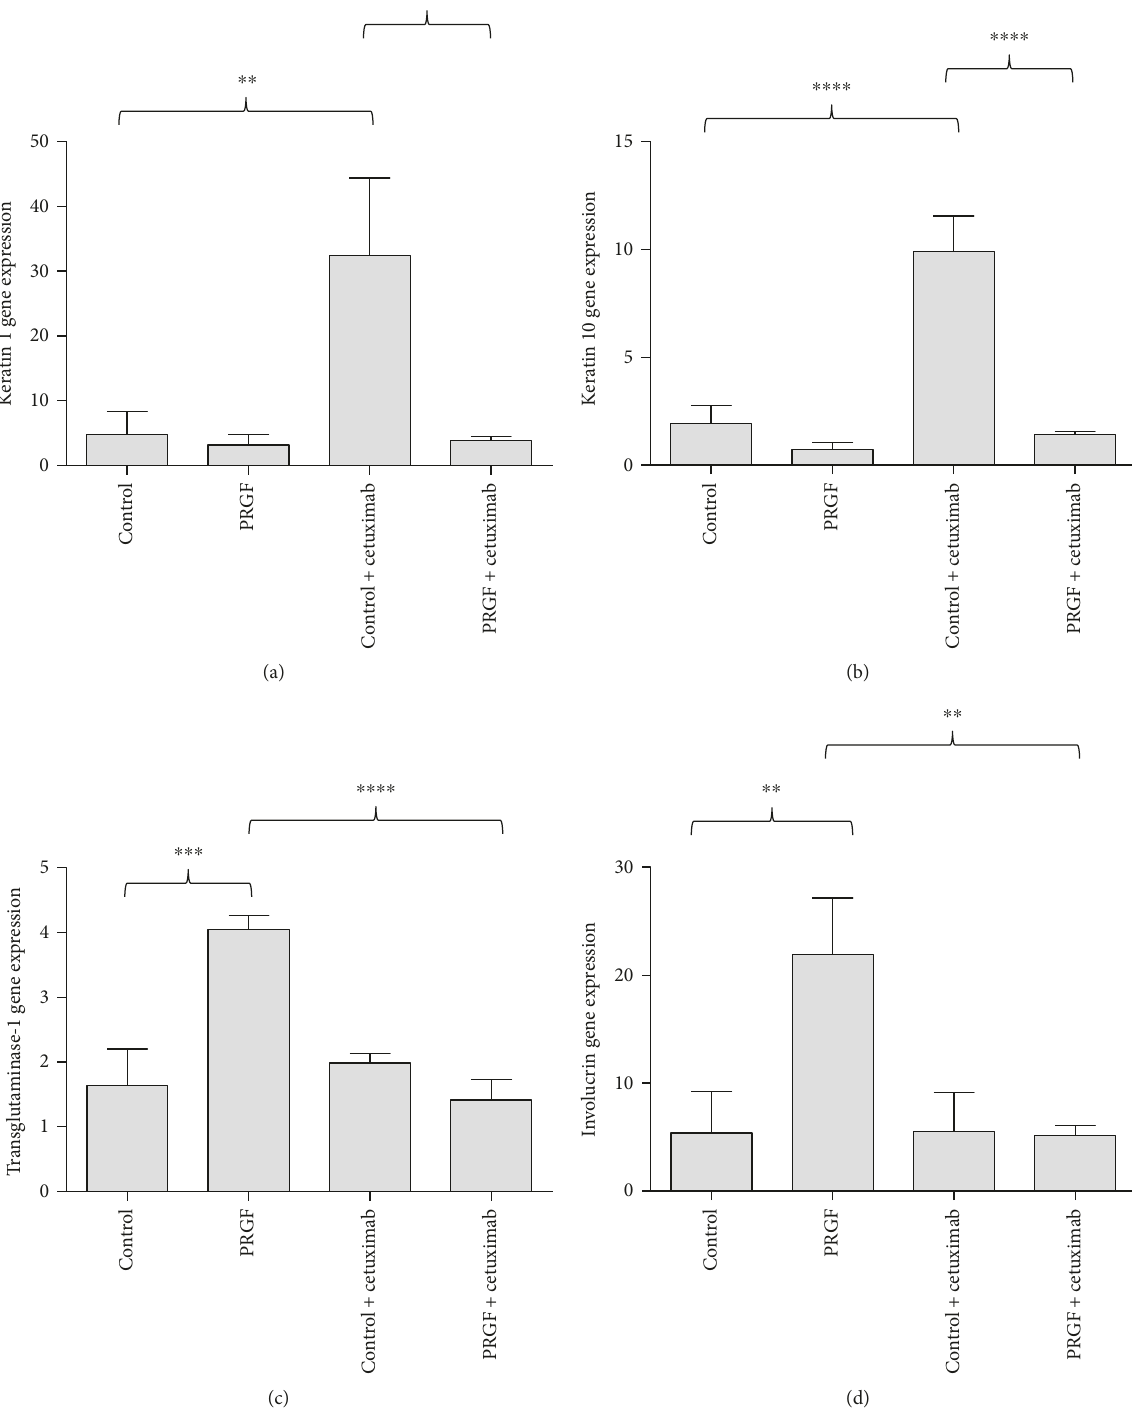
Figure 4: The epidermal growth factor receptor (EGFR) partially mediated the keratin 1, keratin 10, transglutaminase-1, and involucrin gene expression in keratinocytes stimulated with PRGF. PRGF stimulation of primary human keratinocytes caused a reduced keratin 1 and keratin 10 gene expression and an induced transglutaminase-1 and involucrin gene expression. Costimulation with the EGFR-blocking antibody cetuximab revealed that these e ff ects were mediated via the EGFR (real-time PCR analysis, ∗∗ P < 0 01 , ∗∗∗ P < 0 001 , ∗∗∗∗ P < 0 0001 , one-way ANOVA with Tukey ’ s multiple comparison